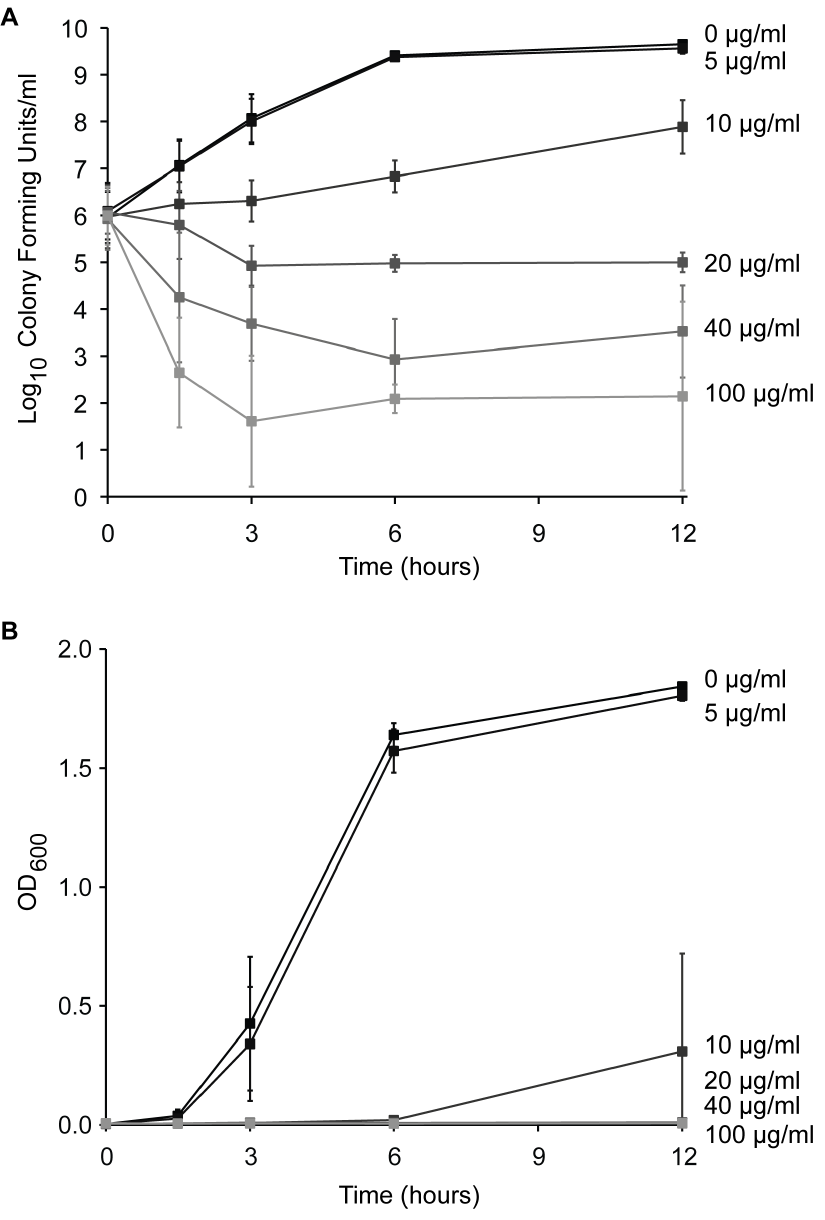
Figure 2. Time-kill and growth curves for E.coli with increasing ciclopirox concentrations. ATCC H 25922 TM E. coli were grown with the indicated ciclopirox concentrations. (A) Cell densities were measured for three independent cultures by counting the number of colony forming units per 1 ml of culture for 12 hours. (B) The corresponding OD 600 of growing cultures were measured over 12 hours. Error bars are the standard deviation from the